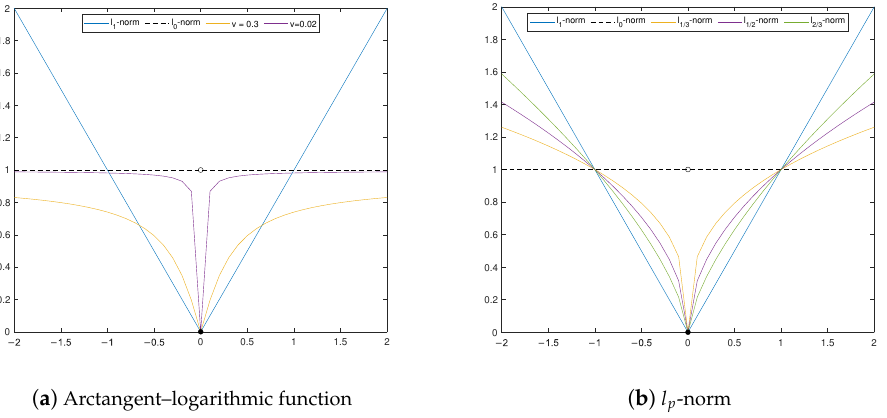
Figure 6. The explanation of nonconvex approximations of l 0 pseudo